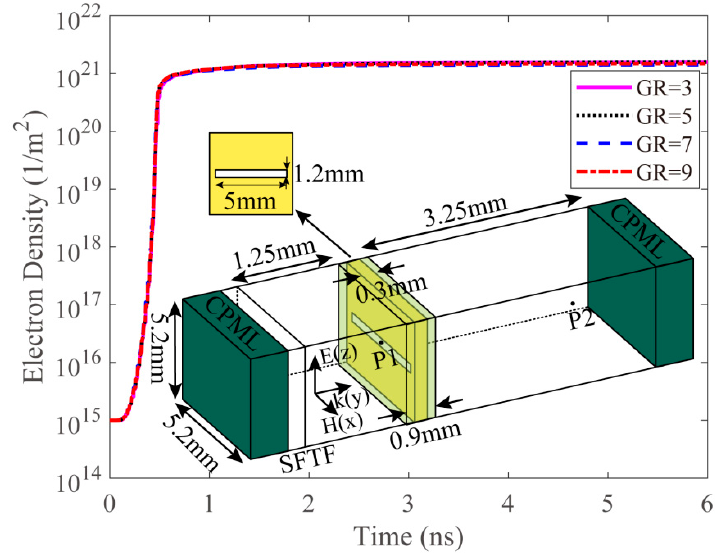
Figure 6. Temporal evolution of the electron density recorded at P1 for different GRs and the illus- tration of the solution domain of the microwave breakdown problem.